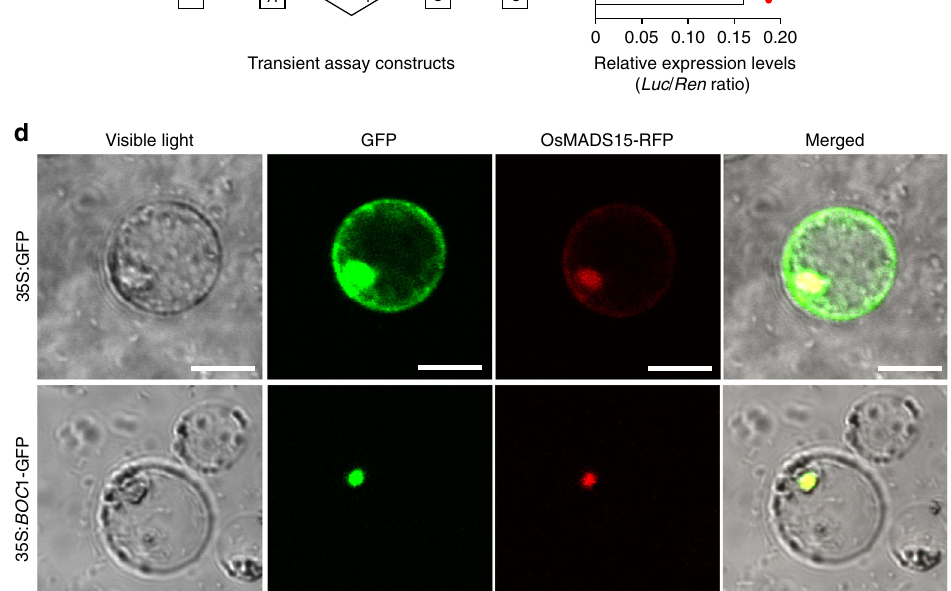
Fig. 4 Transcriptional characterization of BOC1 . a Expression analysis of BOC1 in calli at different stages of subculture. Data are means, with bars showing SE, n = 3 biological replicates. Two-tailed Student ’ s t -tests were performed to determine signi fi cant differences. b BOC1 expression patterns in Teqing and YIL25 calli subcultured for 21 days, as revealed by mRNA in situ hybridization. Thirty calli each from Teqing and YIL25 were collected for mRNA in situ hybridization. Scale bars, 100 μ m. c Transient expression assays of the effects of InDels and SNPs in the BOC1 promoter. Top, structure of the pGreenII 0800- LUC vector. Left, constructs with site-directed mutagenesis of the BOC1 promoter. Luc , the target promoter controlling the fi re fl y luciferase reporter gene. The Renilla ( Ren ) luciferase reporter gene was used as an internal control. M1 to M5 indicate the constructs with site-directed mutations at the 337 bp InDel, three SNPs, and 1 bp InDel. Right, expression levels of Luc relative to Ren . Data are presented as mean ± SE. Horizontal bars show the SE for all constructs ( n = 10 biological replicates, two-tailed Student ’ s t -tests). d Subcellular localization of BOC1 protein in rice protoplast cells. OsMADS15 is a nuclear localization marker. Scale bars, 20 μ m. P -values of ( a , c ) were calculated with two-tailed Student ’ s t -tests. The subcellular localization assays were performed with three biologically independent experiments. Source data underlying Figs. a , c are provided as a Source Data fi